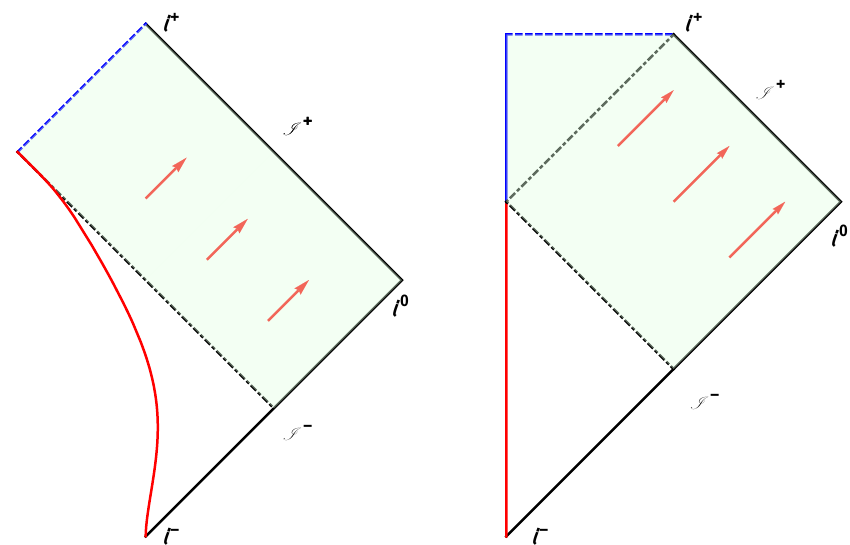
Figure 3. ( Left ) The 1+1 dimensional Penrose diagram for the black hole collapse mirror. The red line is the mirror, Equation (5), computed with κ = 2 for illustration. The dotted black line is the horizon, v H = 0. The blue dashed line is the upper-half of the left future null-infinity Cauchy surface, I + (unlabeled), that acts as a singularity analog. Notice the light green opaque region is where L left-moving modes never reflect off the mirror and get “trapped”, never to become right-movers. The red arrows are Hawking radiation emitted by the mirror or they can be left-movers that reflected off the mirror into right-movers reaching I + . ( Right ) The usual 3+1 dimensional Schwarzschild causal structure captured in a Penrose diagram. The blue dashed line is the space-like singularity while the blue solid line is r = 0 where modes pass through but still hit the singularity. The black dotted dashed line is the event horizon. The red arrows are Hawking radiation or they can be left-movers that passed through r = 0, “reflected” and become right-movers. They will eventually escape to the observer at I + . Notice the light green opaque region where left-movers are lost into the